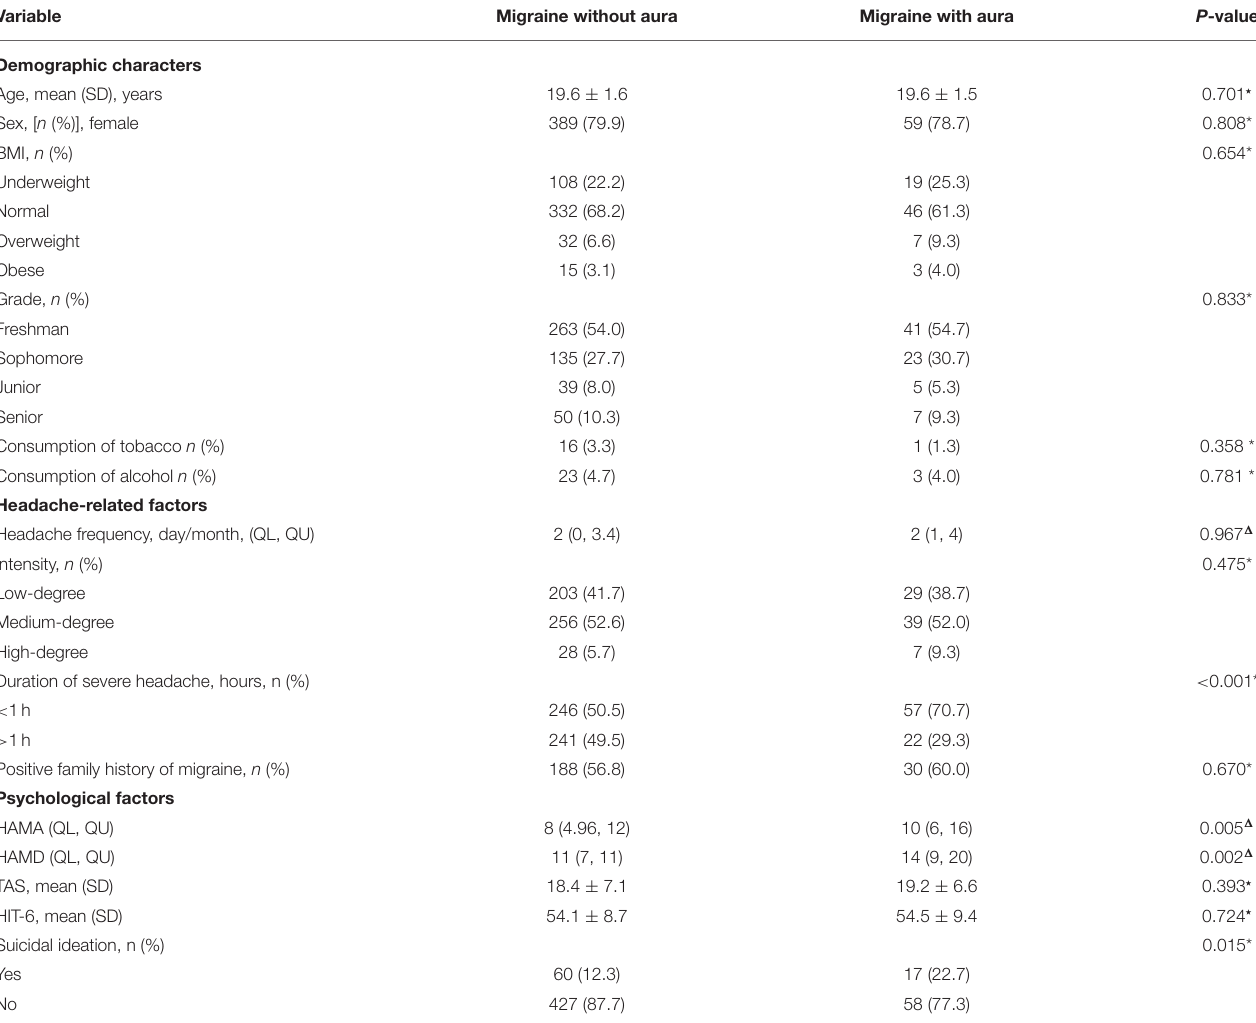
TABLE 1 | Characteristics of the study population. Variable Migraine without aura Migraine with aura P